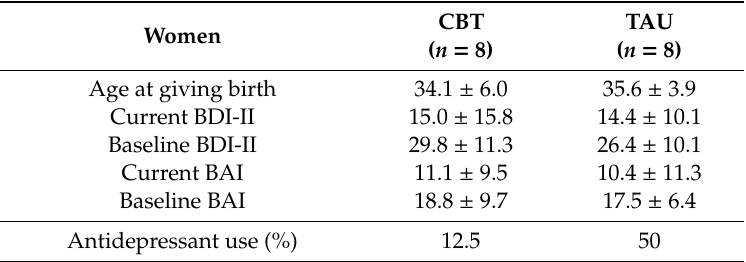
Table 2. Current demographics of women and their children approximately six years after antenatal depression treatment in a pilot Randomized Controlled Trial comparing Cognitive Behavioral Therapy (CBT) and Treatment as Usual (TAU) for antenatal